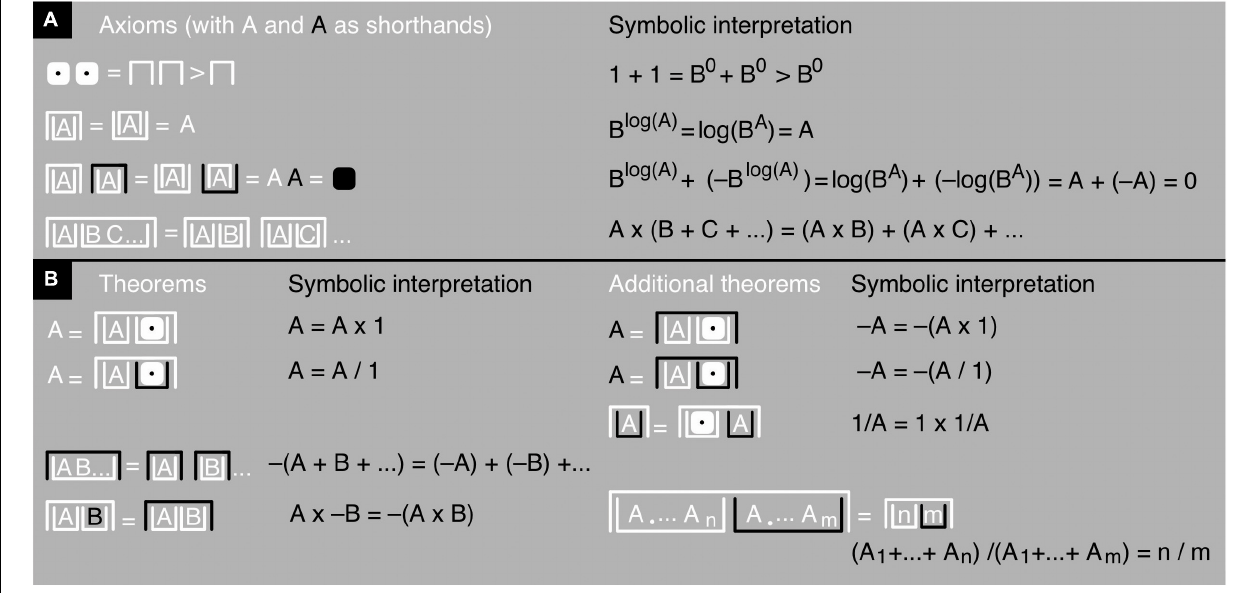
FIGURE 7 | Iconic math’s axioms and a few iconic theorems. (A) The axioms of James algebra (slightly altered) shown in black-and-white notation (left) and accompanied by a symbolic interpretation (right). The first line says that 1+1 > 1, which means 1+1 adds up to more than 1 (namely, 2). It follows that 1+1+1 adds up to even more (namely, 3) and so on. (B) Iconic theorems and additional ones added by me myself, derived from the iconic axioms shown in (A) and accompanied by symbolic interpretations. In the last additional iconic theorem, an A with a dot as a subscript should be read as A 1 , meaning the first copy of A, and A n and A m as the nth and mth copies of A. Intervening dots stand for intervening copies of A. So, the theorem shows n copies of A in the first upright container and m copies of A in the second